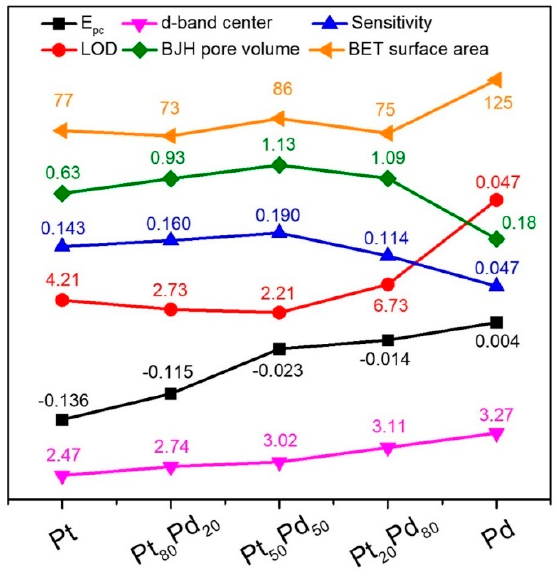
Figure 7. The relationship between the ratio of Pt and Pd in the as-prepared Pt x Pd y aerogels and their sensitivity (mA mM − 1 cm − 2 ), LOD ( µ M), E pc (V), BET surface area (m 2 g − 1 ), BJH pore volume (cm − 3 g − 1 ), and d-band center